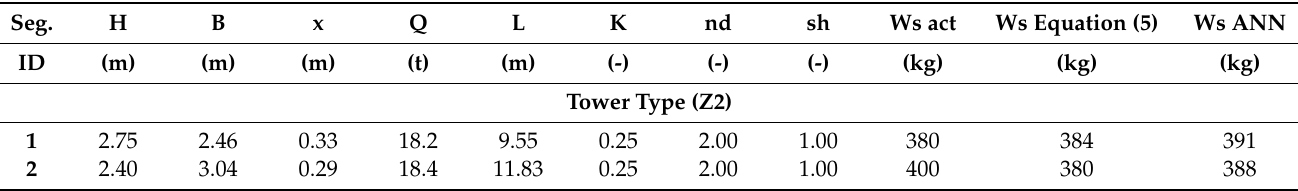
Table 6. Summary of the verification